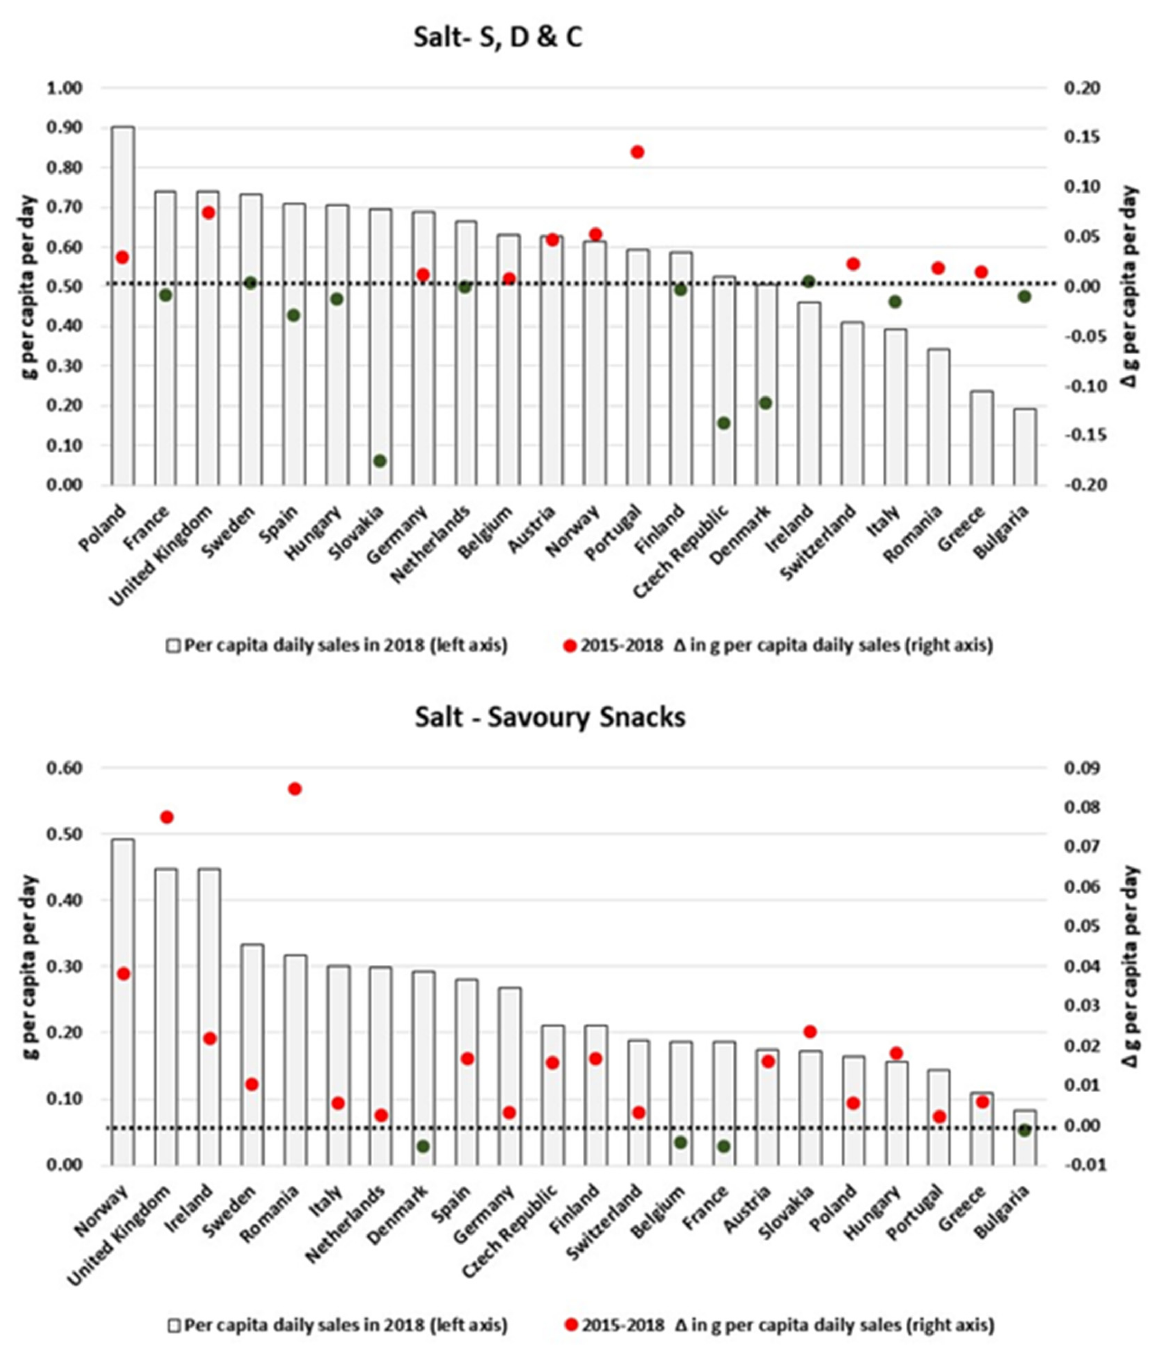
Figure 8. Estimates of salt sold through S, D & C and Savoury Snacks in 2018 and the respective 2015–2018 variation (in g/pc/day). Source: Elaborated by the authors based on data from Euromonitor (2020) and mid-year population estimates from the HFA-DB. Estimates were scaled by market coverage to represent 100% of the retail market. The right-hand axis represents the nutrient variation in g per capita per day (green for negative values, red for positive values), and the dotted black line indicates the variation of 0 g per capita per day as a reference.